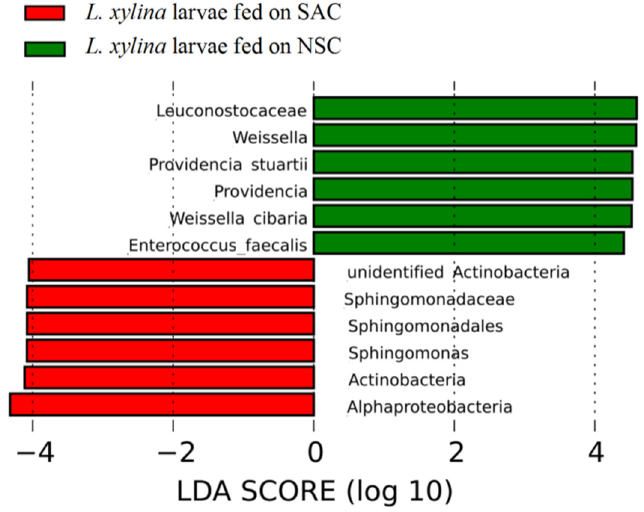
Figure 5. LEfSe analysis of the LDA distribution histogram of the gut microbiota across seven instars for L. xylina larvae fed on the SAC and NSC diets.